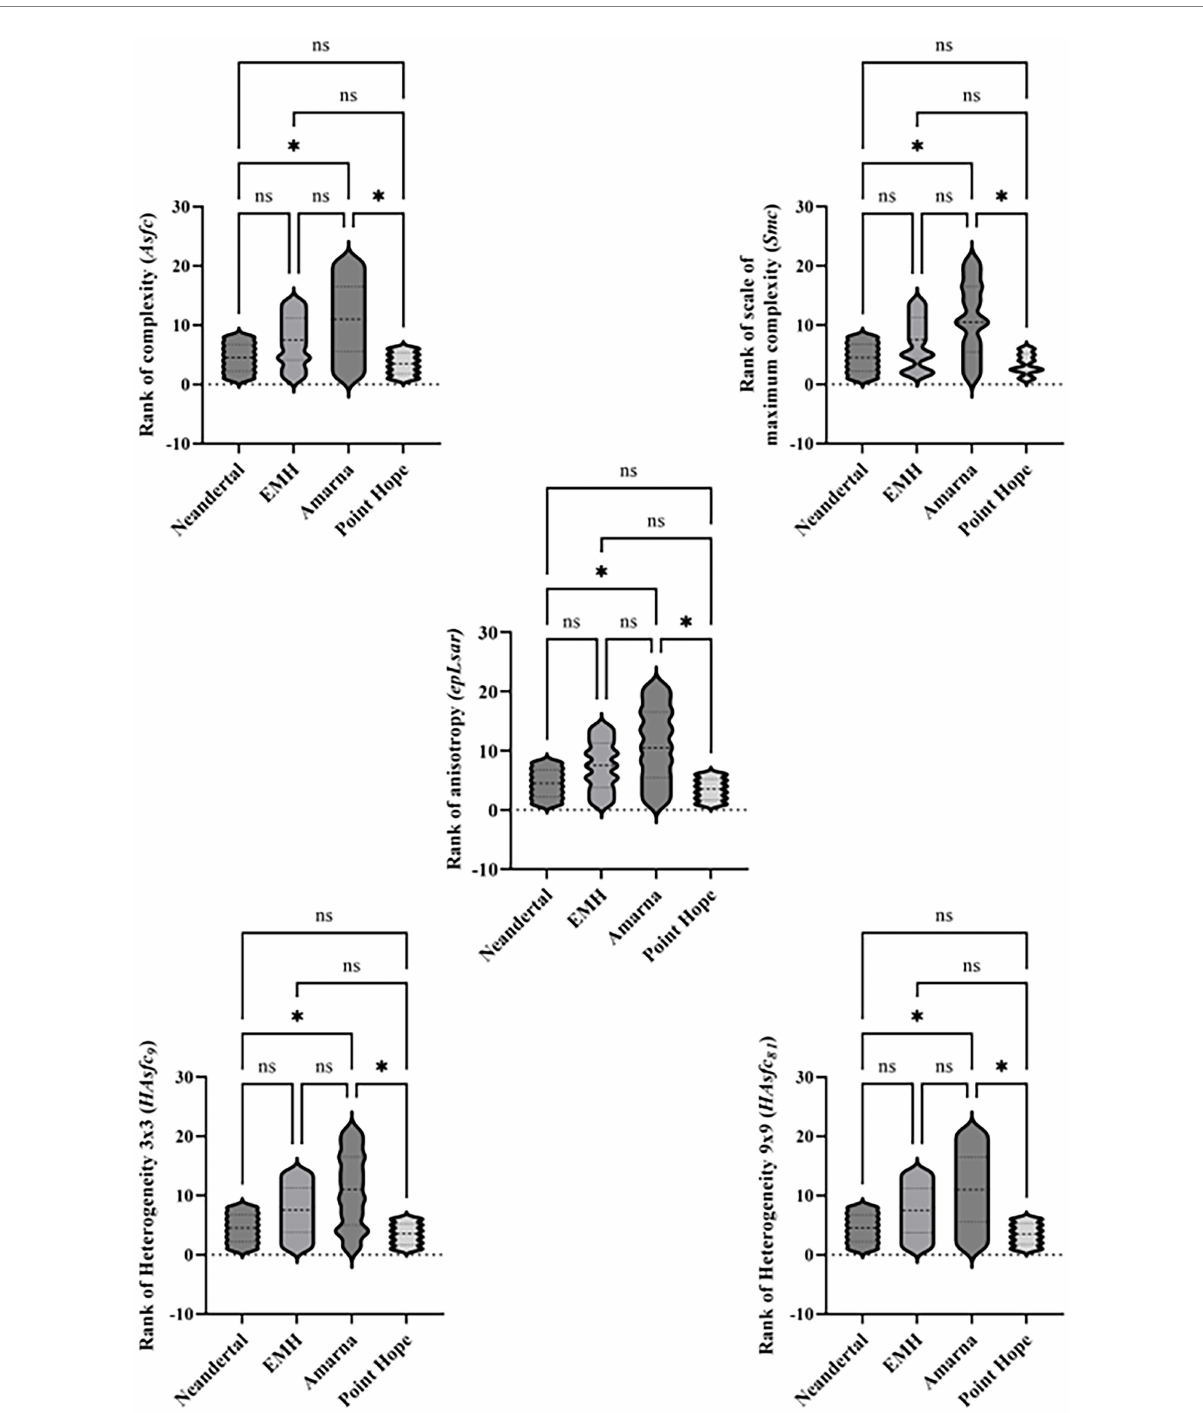
FIGURE 2 Violin plots with pairwise comparisons of ranked microwear data by variable. Two dotted lines and one single dashed line within each violin plot represent quartiles and median, respectively. * = significant difference and ns = no significant difference between the two